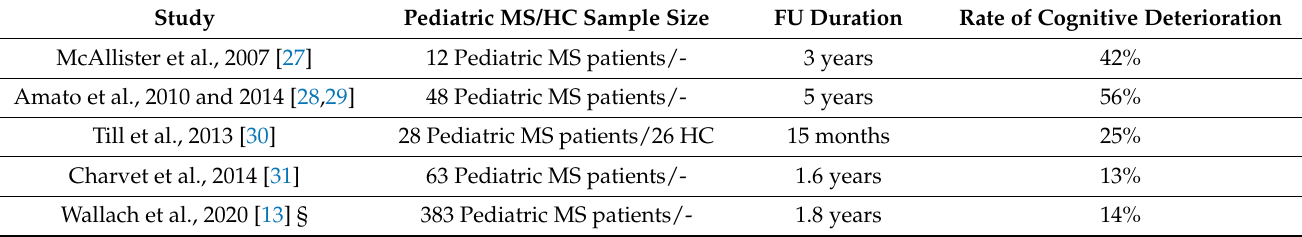
Table 2. Main longitudinal studies * on cognitive impairment in pediatric multiple sclerosis